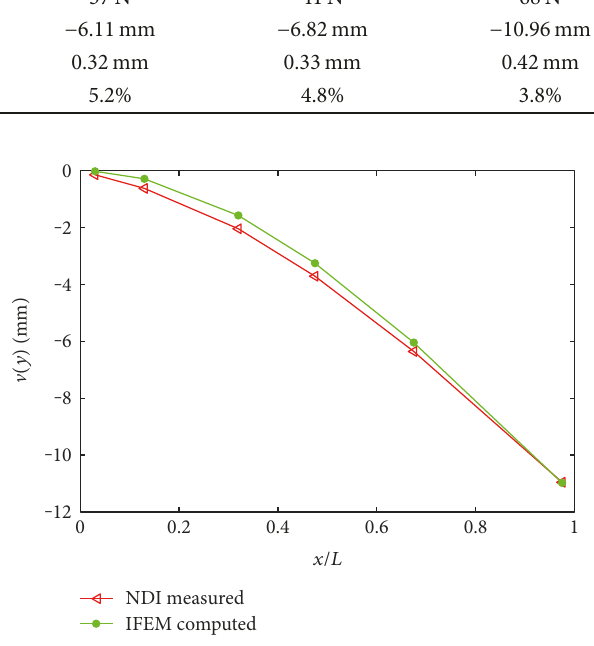
Figure 7: Comparison of iFEM reconstruction for a beam to NDI measurement in Y .